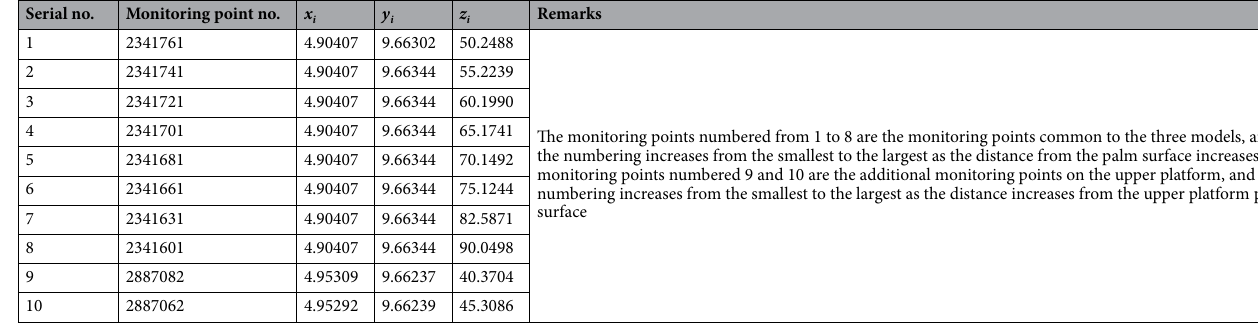
Table 5. Monitoring point coordinates (units: m).